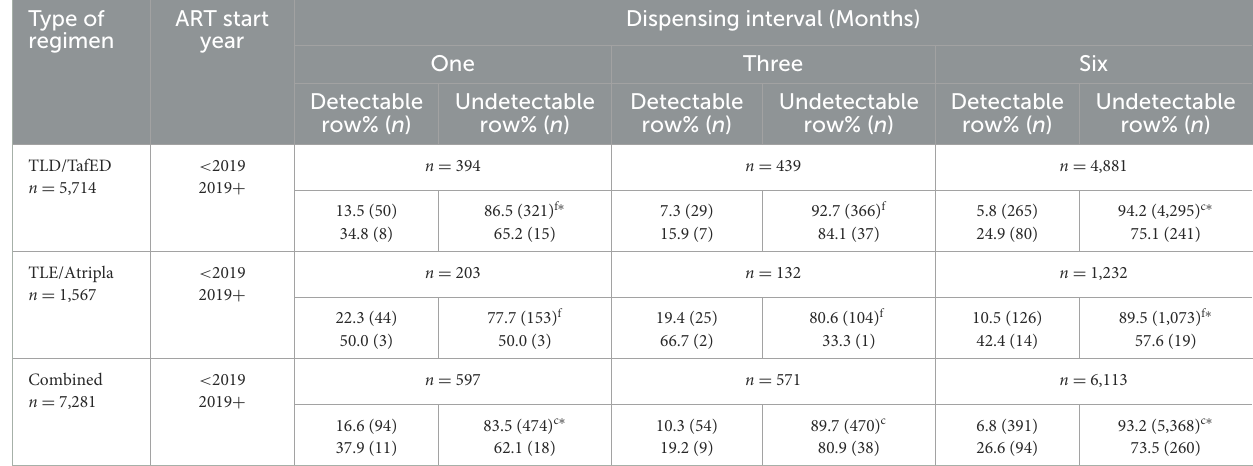
TABLE 2 Viral detectability (detectable vs. undetectable) by U = U campaign categories among adult PLWHIV receiving ART at the AIDC of UTH in Lusaka, Zambia, stratified by type of first-line ART regimen and dispensing interval.